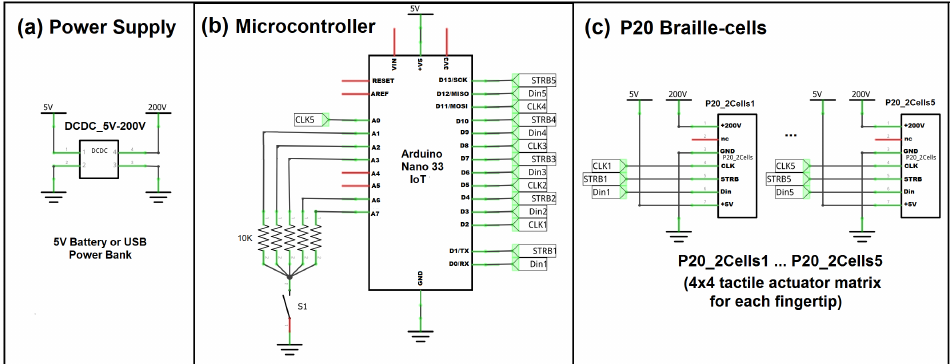
Figure 4. Whole system schematic of the untethered high-resolution haptic hand wearable: ( a ) power supply block, ( b ) microcontroller block, and ( c ) P20 Braille cells